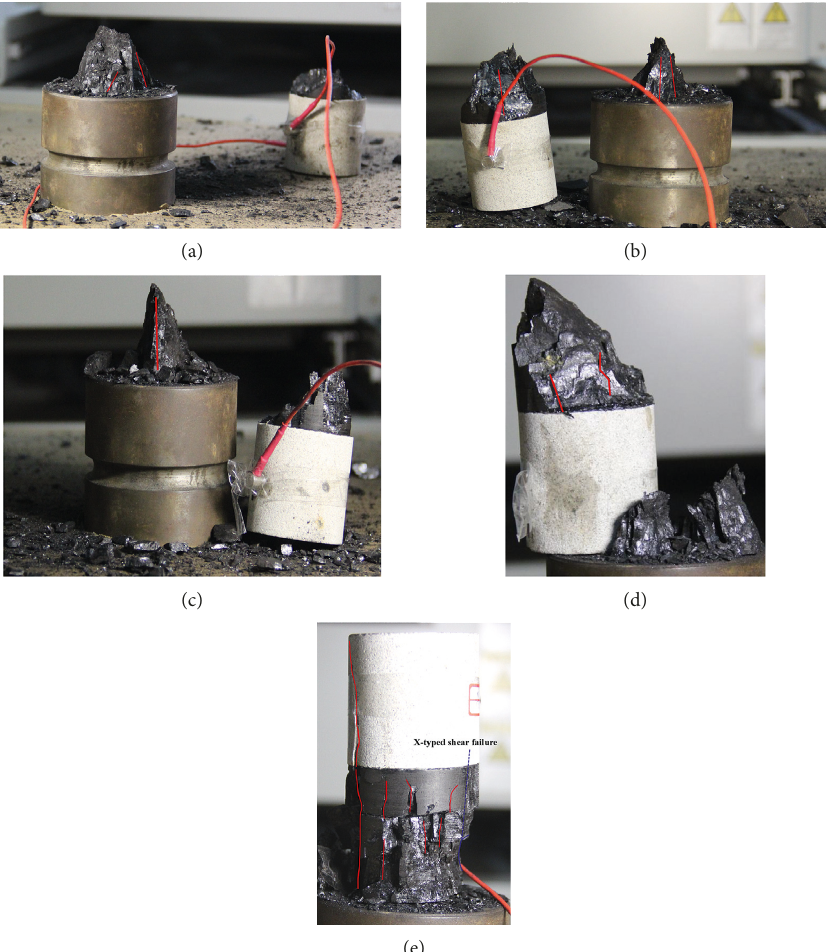
Figure 7: Typical failure models of composite samples. (a) A-1. (b) A-2. (c) A-3. (d) A-4. (e)